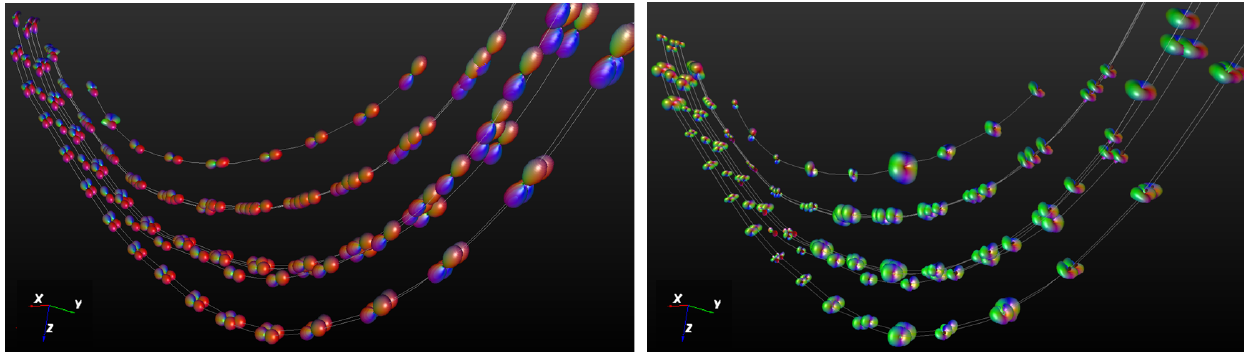
Figure 5. Corpus callosum fibers: ( left ) the corresponding ODFs per fiber voxel and ( right ) the corresponding inverted ODFs per fiber voxel.